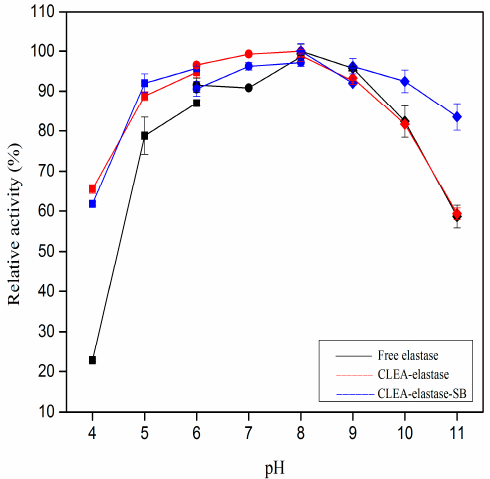
Figure 6. The pH stability profile of free elastase and CLEA–elastase derivatives. For every pH a di ff erent bu ff er system with a concentration of 50 mM was provided, and the bu ff er systems comprised sodium acetate ( (cid:4) ), potassium phosphate ( (cid:8) ), Tris–Cl ( (cid:78) ), and glycine–OH ( (cid:95) ). The experiment was conducted in triplicate and relative activities are presented as mean values ± standard error.